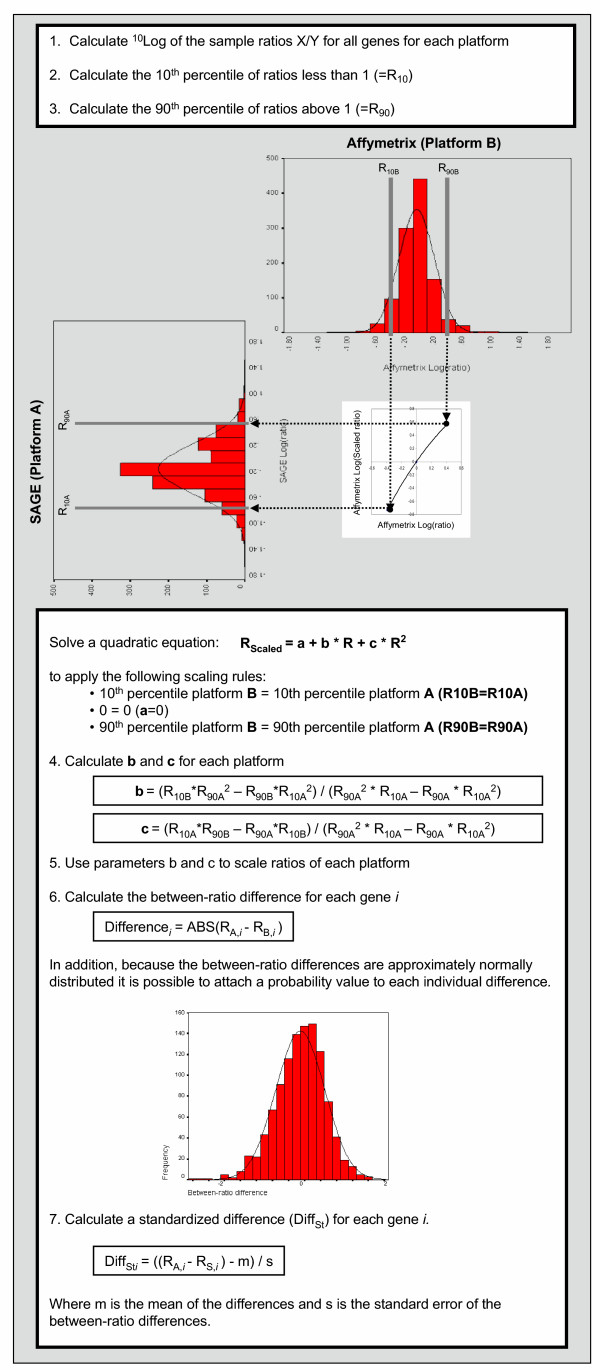
Scaling of two gene expression profiling platforms. Illustration of the steps involved in the scaling of values in each of the platforms to a common scale. The procedure takes the ratio distribution in one of the platforms and scales the other to match the same range of ratio values using a quadratic equation based on ratio 1 and the 10th and 90th percentile values of each platform. The (scaled) ratio values are then used to calculate between-platform ratio differences per transcript. In addition, it is demonstrated how the ratio differences can be used to calculate the standardized between-platform log(ratio) difference and a probability value. For further details: see the Materials and Methods section.